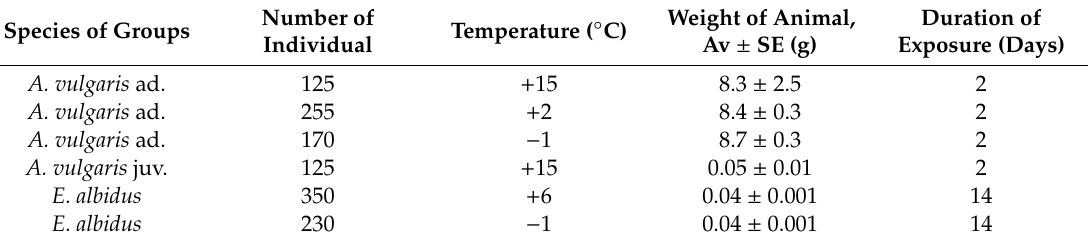
Table 1. List of the tested groups and the main conditions of